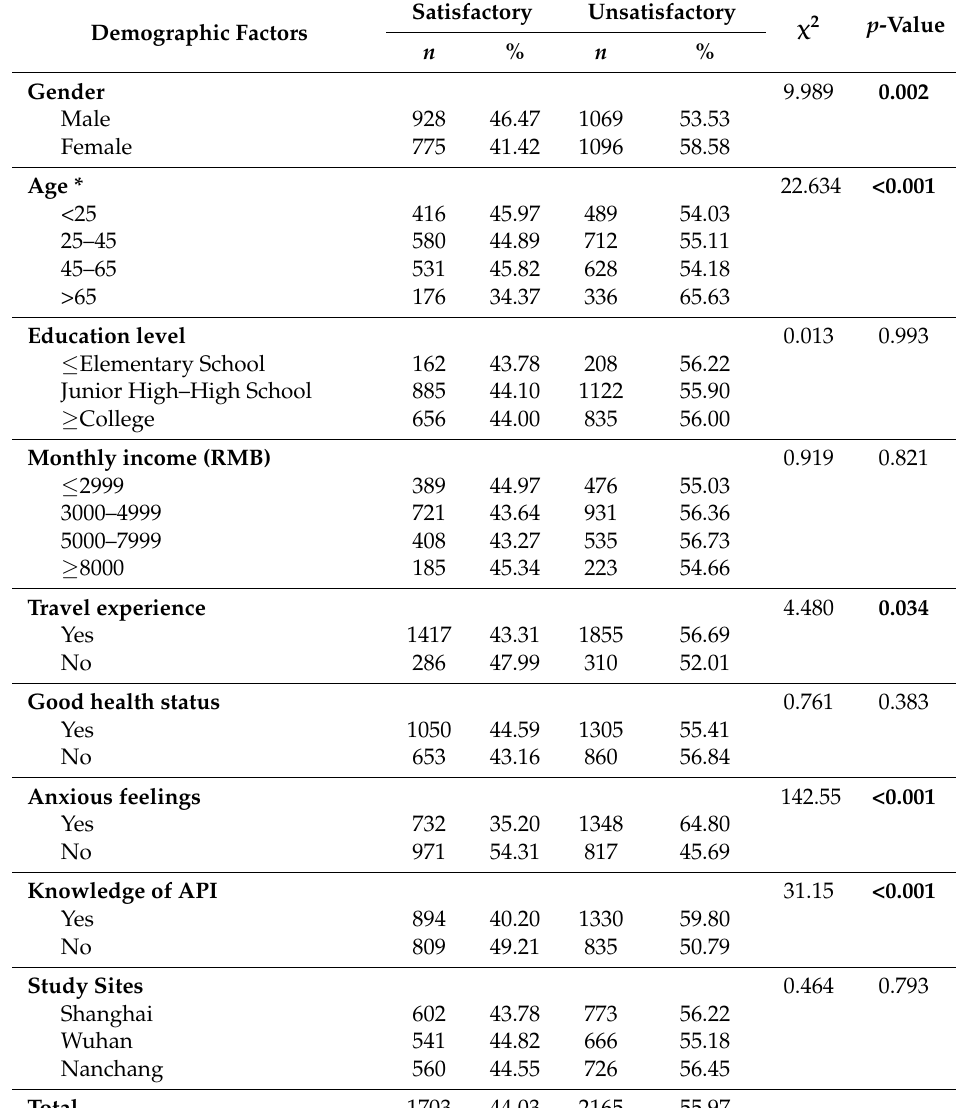
Table 2. Respondents’ general satisfaction of current air